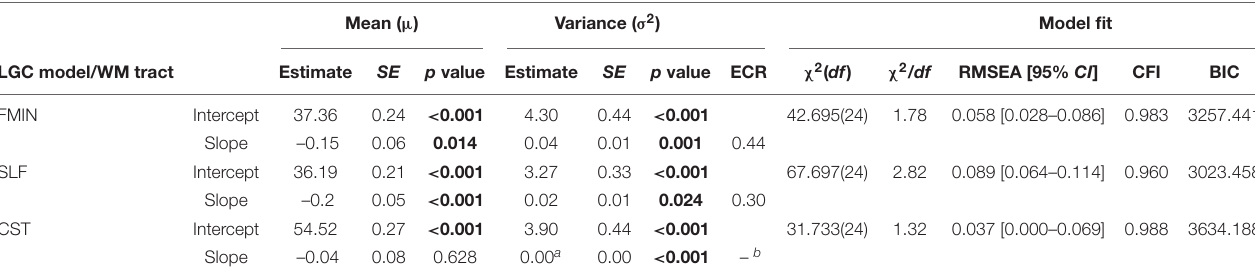
TABLE 3 | Parameter estimates and model fit statistics of best fitting univariate LGC models for WM FA.